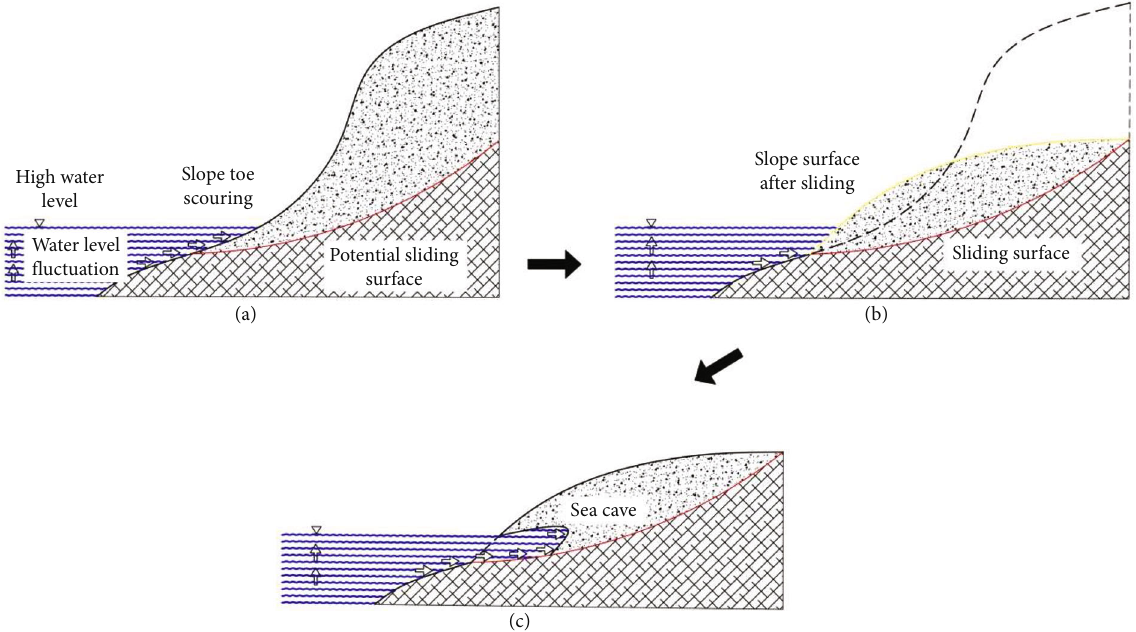
Figure 1: Slope change